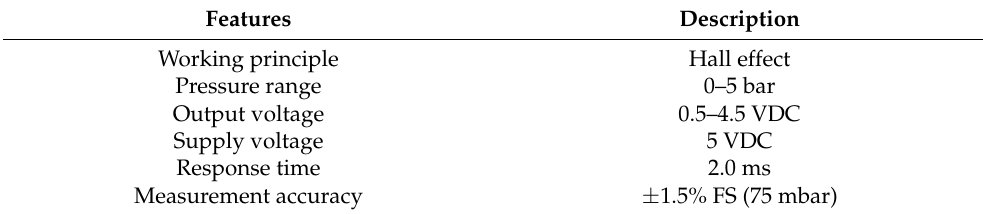
Figure 24. Pressure sensor. Table 2. Features of the pressure